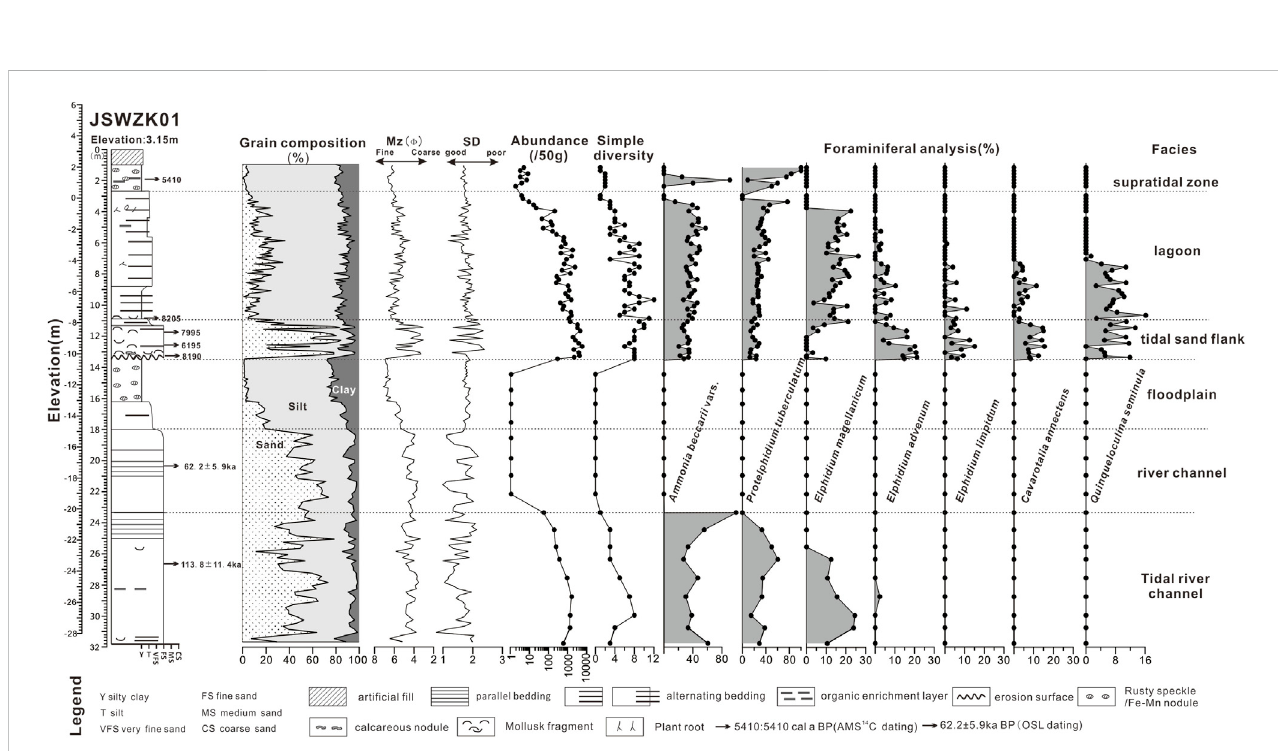
FIGURE 5 Comprehensive stratigraphic log of the core JSWZK01, showing lithology, grain size, and foraminiferal content. The borehole is divided into six sedimentaryfaciesfromthelatePleistocenetidalriverchanneland fl oodplaintotheHolocenetidalsand fl ank,lagoon,andsupratidalzone.Itistobenotethat the foramiferal data (i.e., abundance) changed abruptly at depths of 23.3 m and 13.4 m, indicating the end of Late Pleistocene marine transgression and the initiation of Holocene aggression in the core JSWZK01, relatively. For more detailed foraminiferal data, see Supplementary Table S1 in the